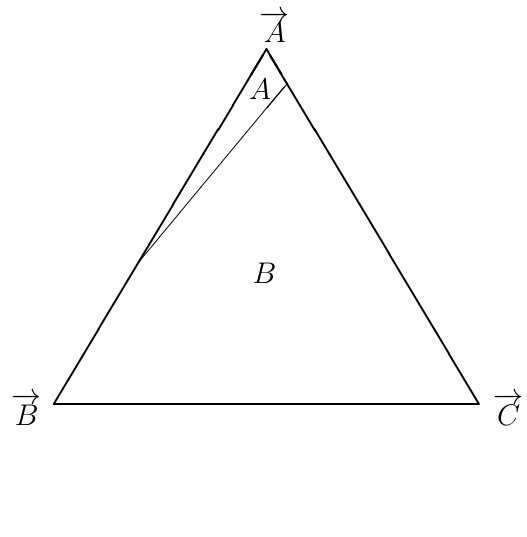
Figure 1 . Best response regions of the extended game ˜ G for large W